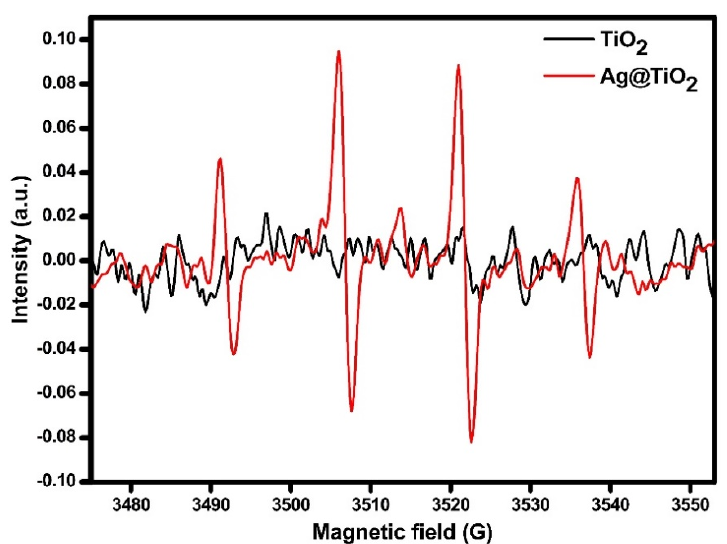
Figure 3. ESR analysis using DMPO as a trapping agent under similar solar light with UV light cut-off (>400 nm).